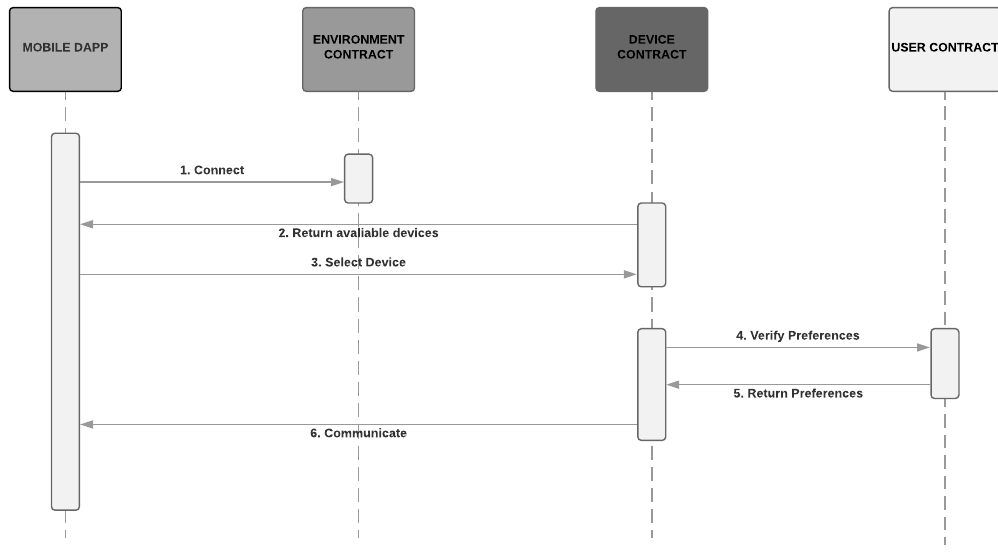
Figure 7. User-Device